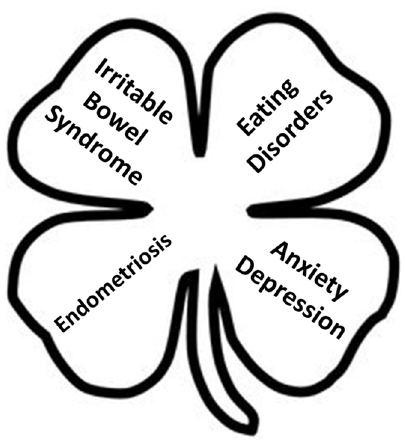
Figure 5. The four-leaf clover.